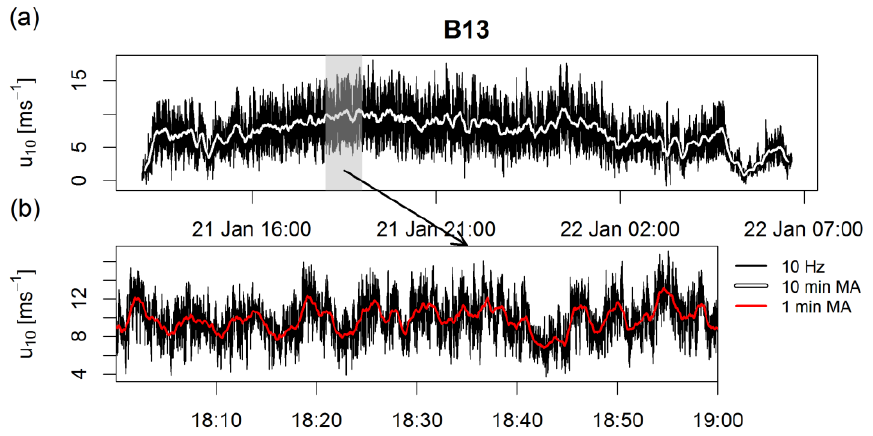
Figure 11. As with Figure 5, but for the bora episode B13 (SA).